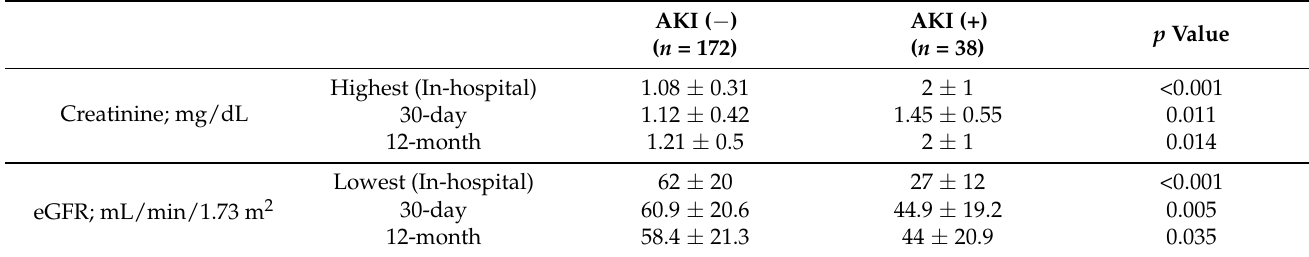
Table 2. Post-TAVI renal function data.